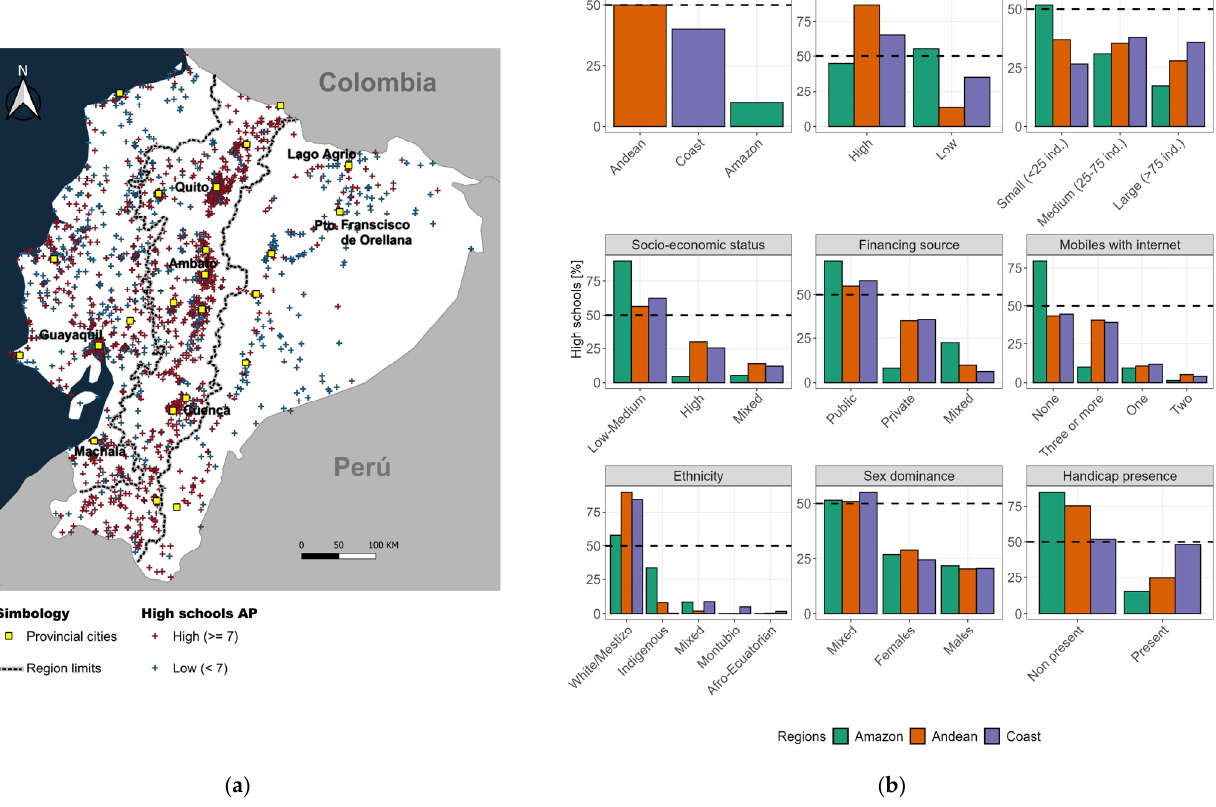
Figure 1. ( a ) High schools, regions, and largest cities in the study area. ( b ) Students’ answers to selected survey questions, presented as percentages of total high schools by region.